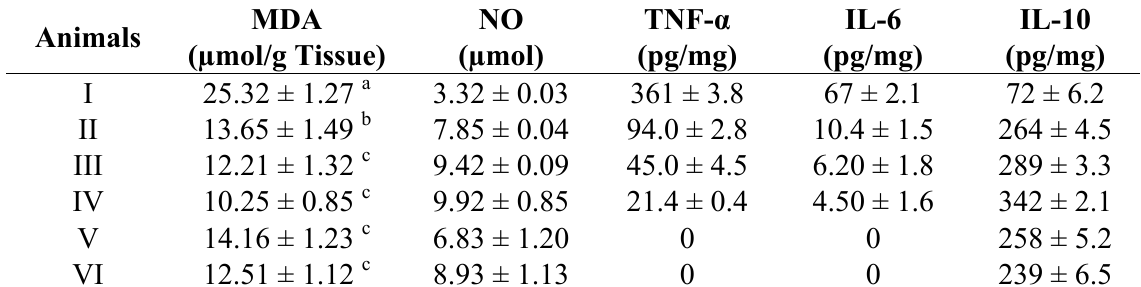
Table 6. Effects of CuLBS on MDA, NO, TNF- α , IL-6 and IL-10 in ulcerated in